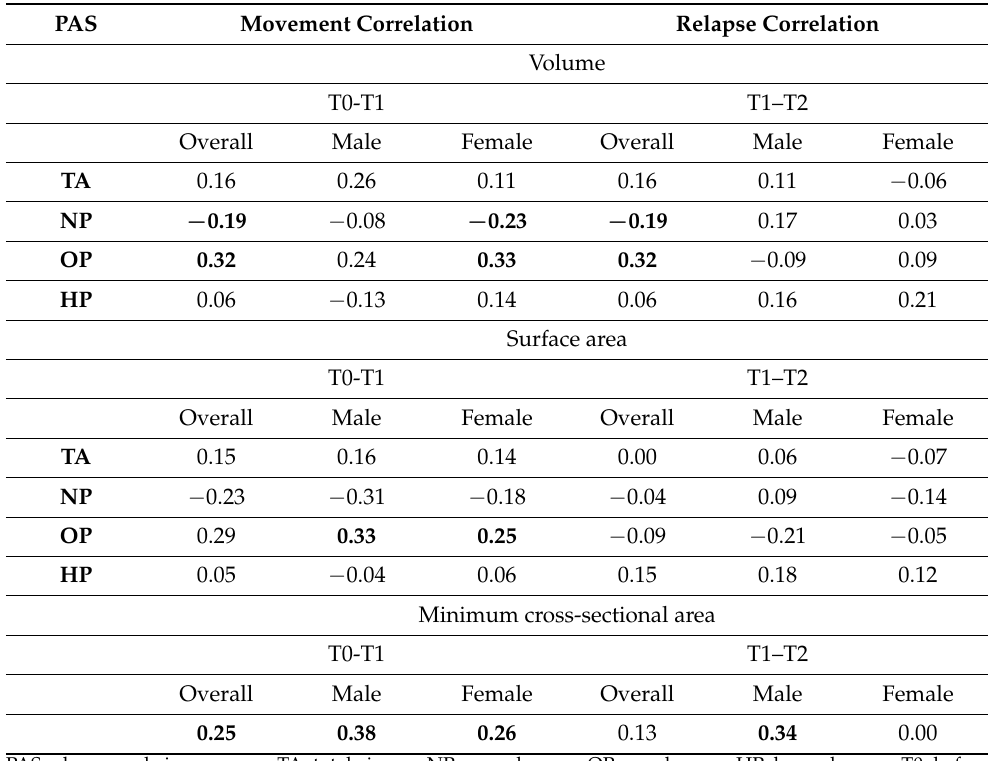
Table 2. Overall and gender-based correlation between pharyngeal airway space and skeletal move- ment and